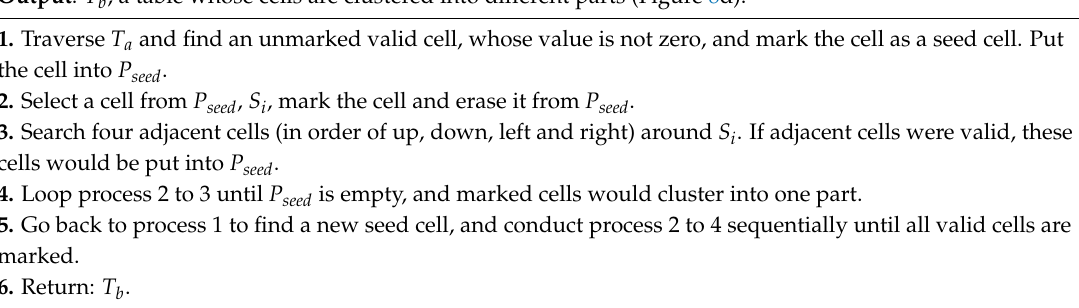
Algorithm 2 . Two-dimensional region growing algorithm